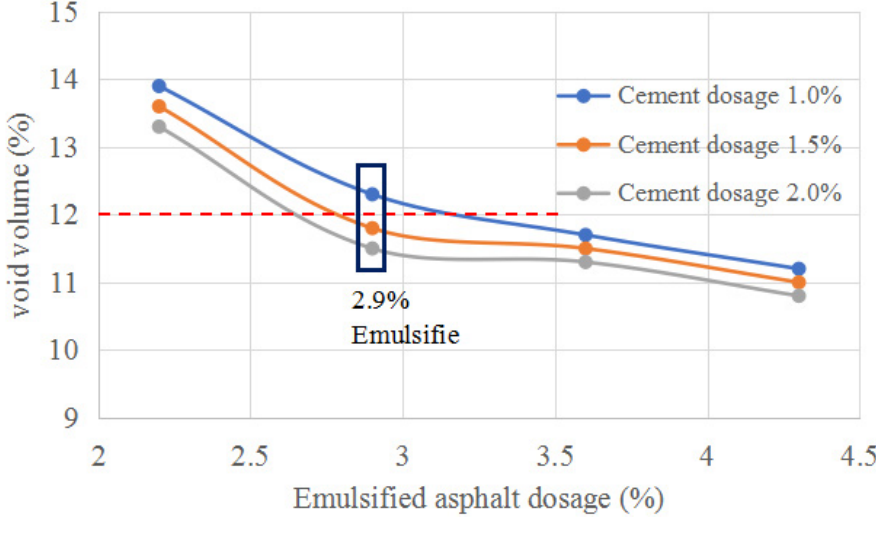
Figure 3. Void volume Trend Chart.